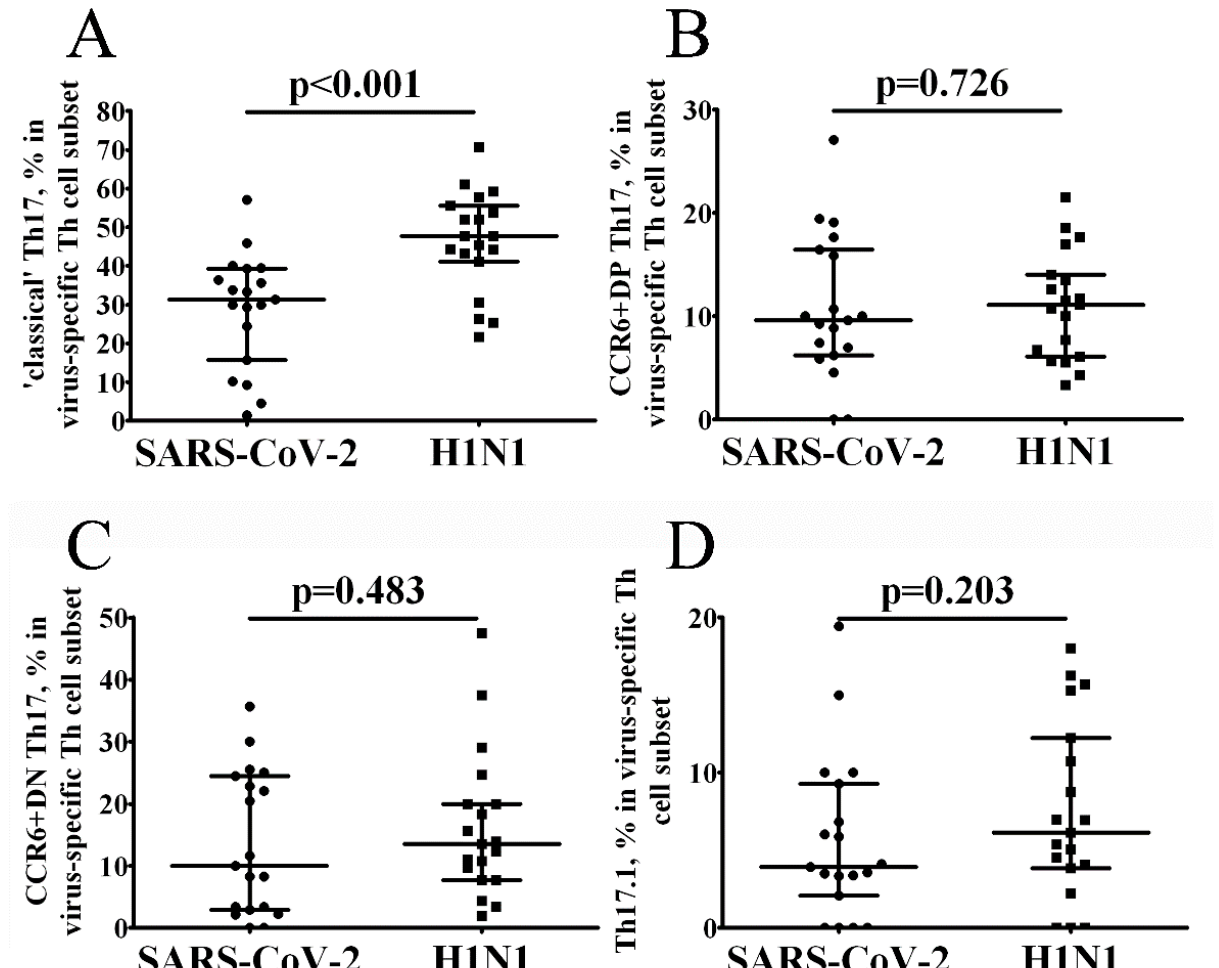
Figure 4. Frequency of circulating SARS-CoV-2- and H1N1-specific Th17 cell. Scatter plots A-D showing the percentages of CCR4+CXCR3– ‘classical’ Th17 ( A ), CCR4+CXCR3+CCR6+ DP Th17 ( B ), CCR4–CXCR3–CCR6+ DN Th17 ( C ) and CCR4–CXCR3+ Th17.1 ( D ) within the total virus-specific Th cell population, respectively. Black circles—SARS-CoV-2-specific CD4+ T cells ( n = 19); black squares—H1N1-specific CD4+ T cells. Each dot represents individual subjects, and horizontal bars represent the group medians and quartile ranges (Med (Q25; Q75). Statistical analysis was per- formed with the Mann-Whitney U test.